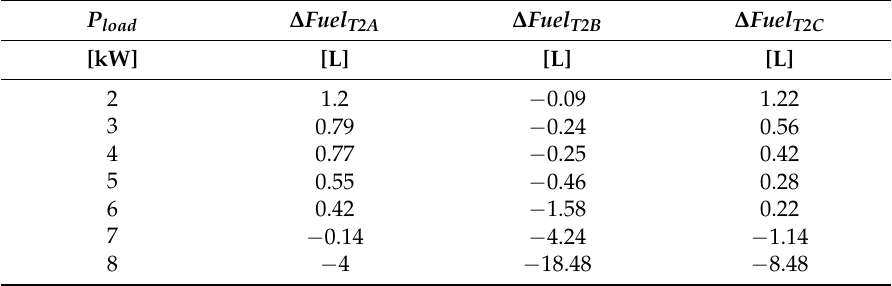
Table 6. Fuel economy for the RTO2 strategy using different k fuel .